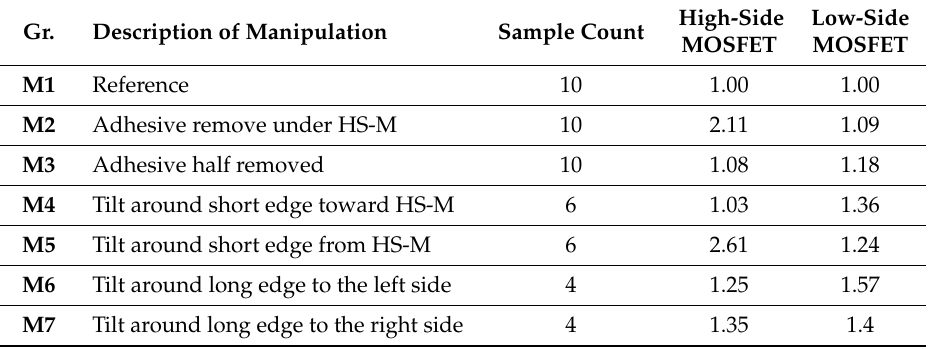
Figure 9. ( a ) Image of the inspected power inverter module in a semi-fabricated state for adhesive investigation with five half bridges on five DBCs attached with nonconductive thermal adhesive to an aluminum body. The sixth DBC holds peripheric components. ( b ) Schematic description of Table 1. Average termination value of each group normalized to HS-M or LS-M of M1. The termination adhesive manipulations on a single DBC/half bridge used for grouping. value does not represent R th since thermal equilibrium was not